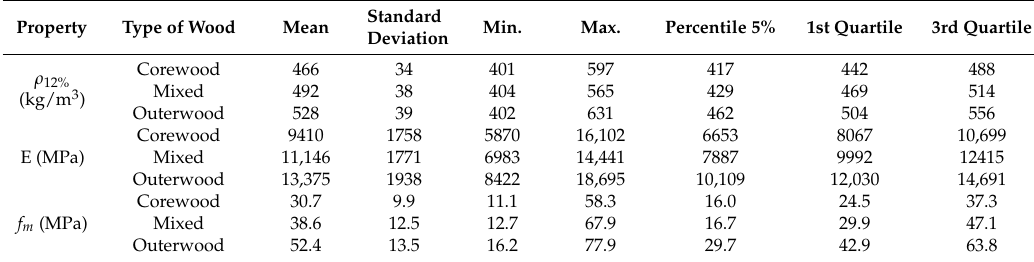
Table 4. Physico-mechanical properties measured on three types of 38 × 100 mm 2 boards: